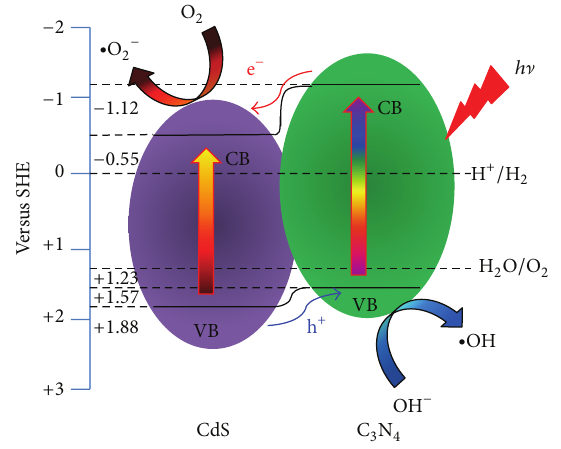
Figure 10: Scheme for electron-hole separation and transport at the visible light driven organic-inorganic composites photocatalyst interface and in between CdS and C 3 N 4